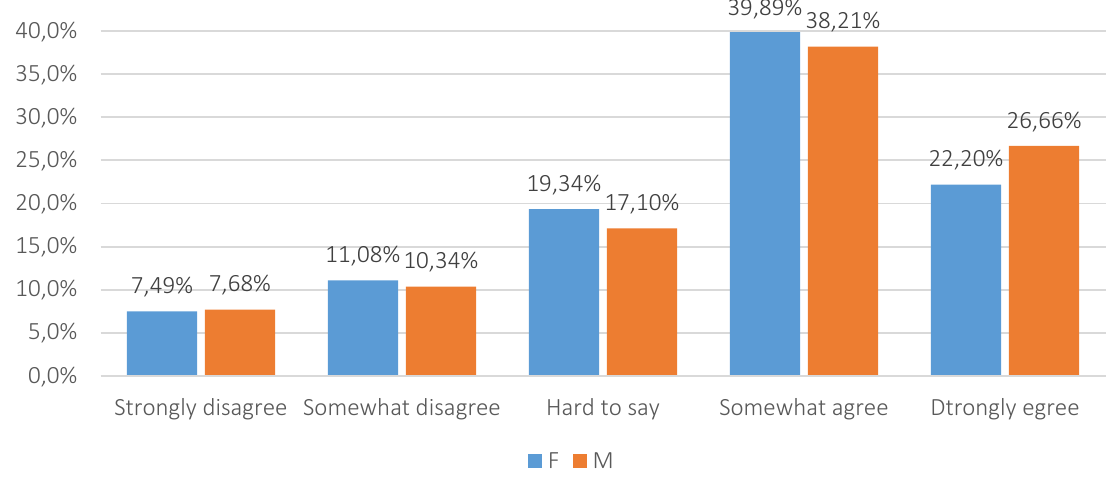
Figure 2. The quality of interpersonal relationships at work vs. a respondent’s sex